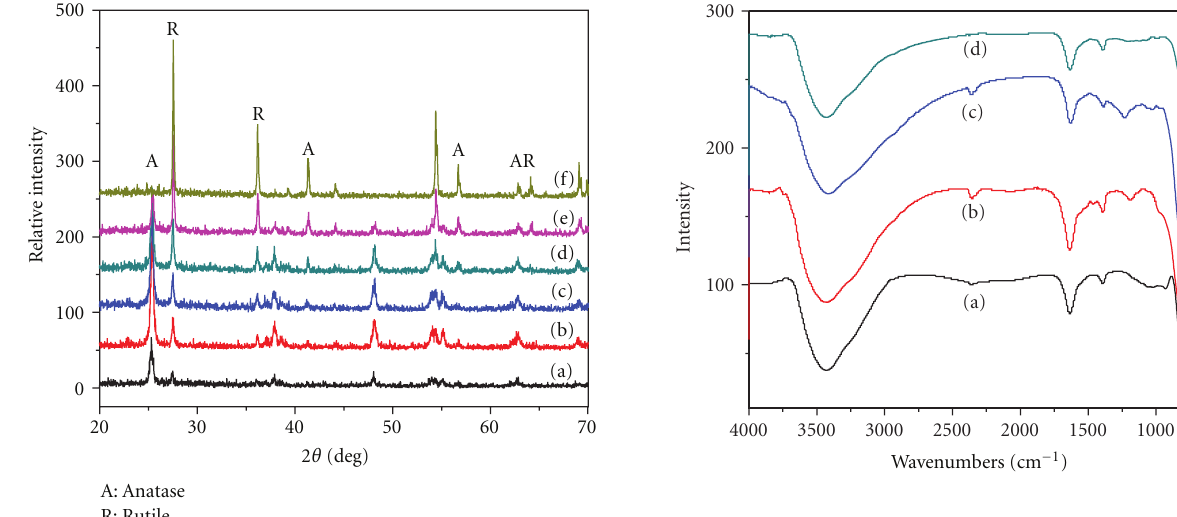
Figure 1: XRD patterns of P25 samples before (a) and after calcination at 400 (b), 500 (c), 600 (d), 700 (e), and 800 ◦ C (f) for 4h.